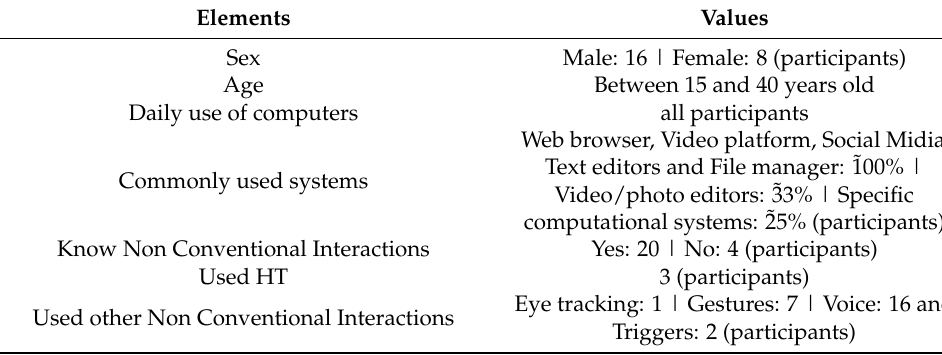
Table 2. Characteristics of participants in the first stage of